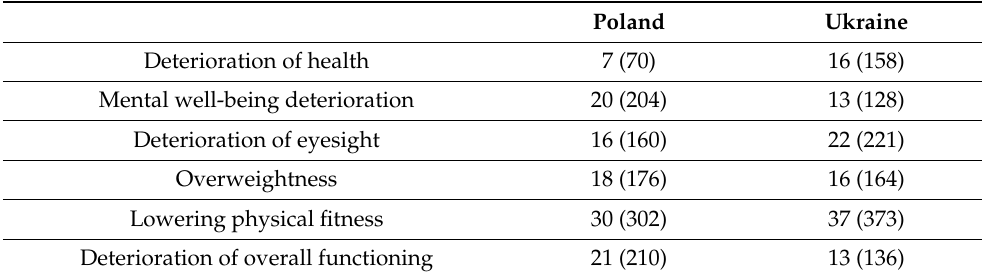
Table 3. Percentage (%) and frequency (N) of answers to questions regarding health